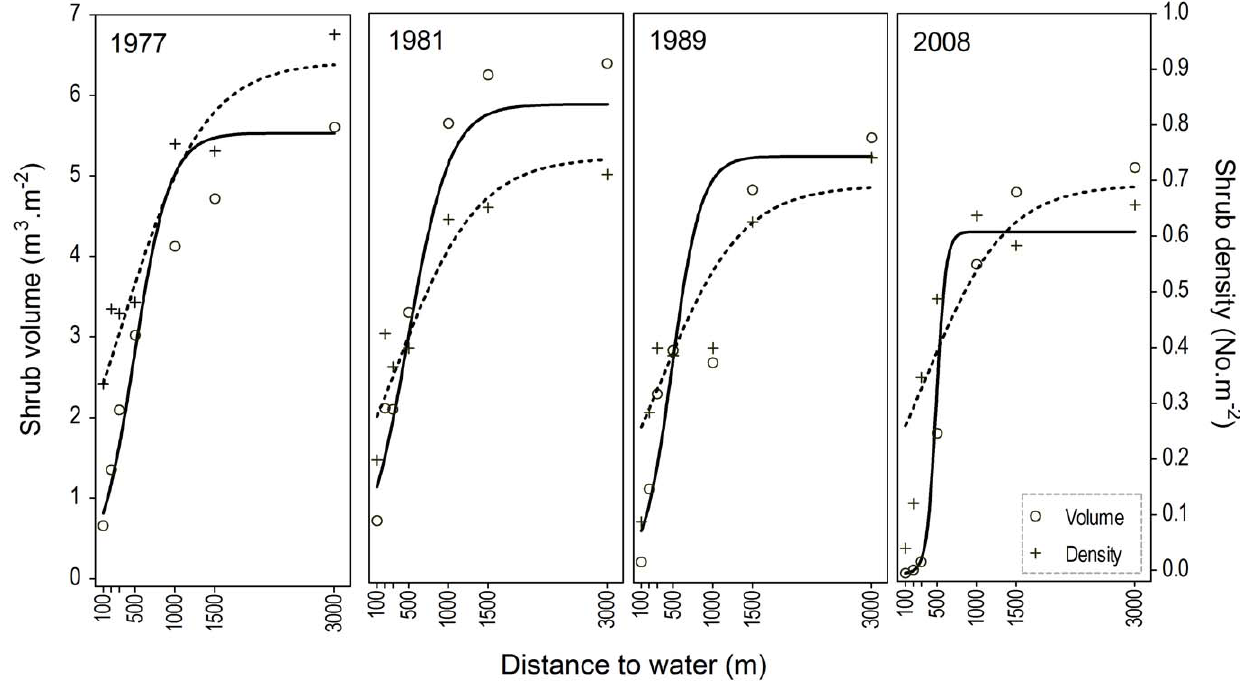
Figure 5. Best-fit mixed-effects logistic growth models of canopy shrub volume (solid lines; circles) and shrub density (dashed lines; crosses) as a function of distance from water.